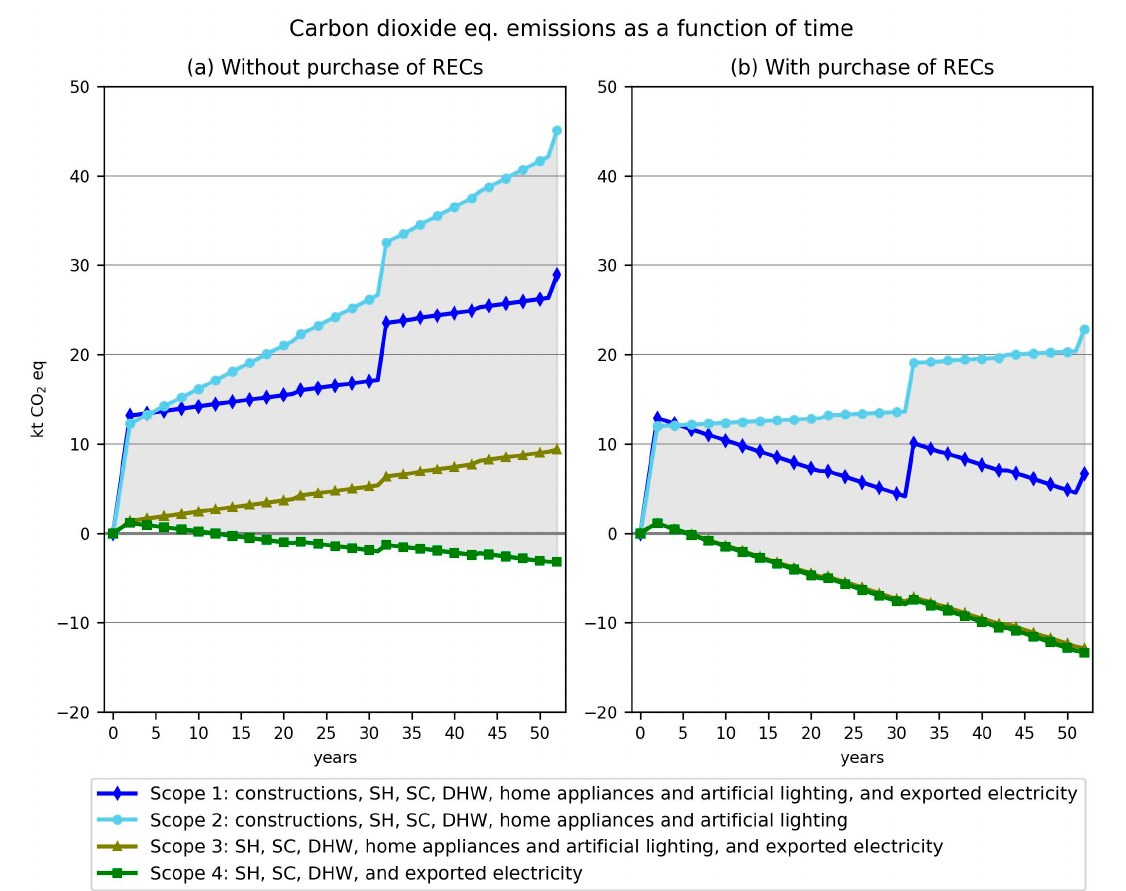
Figure 9. Percentage results by ( a ) contributors and ( b ) modules.